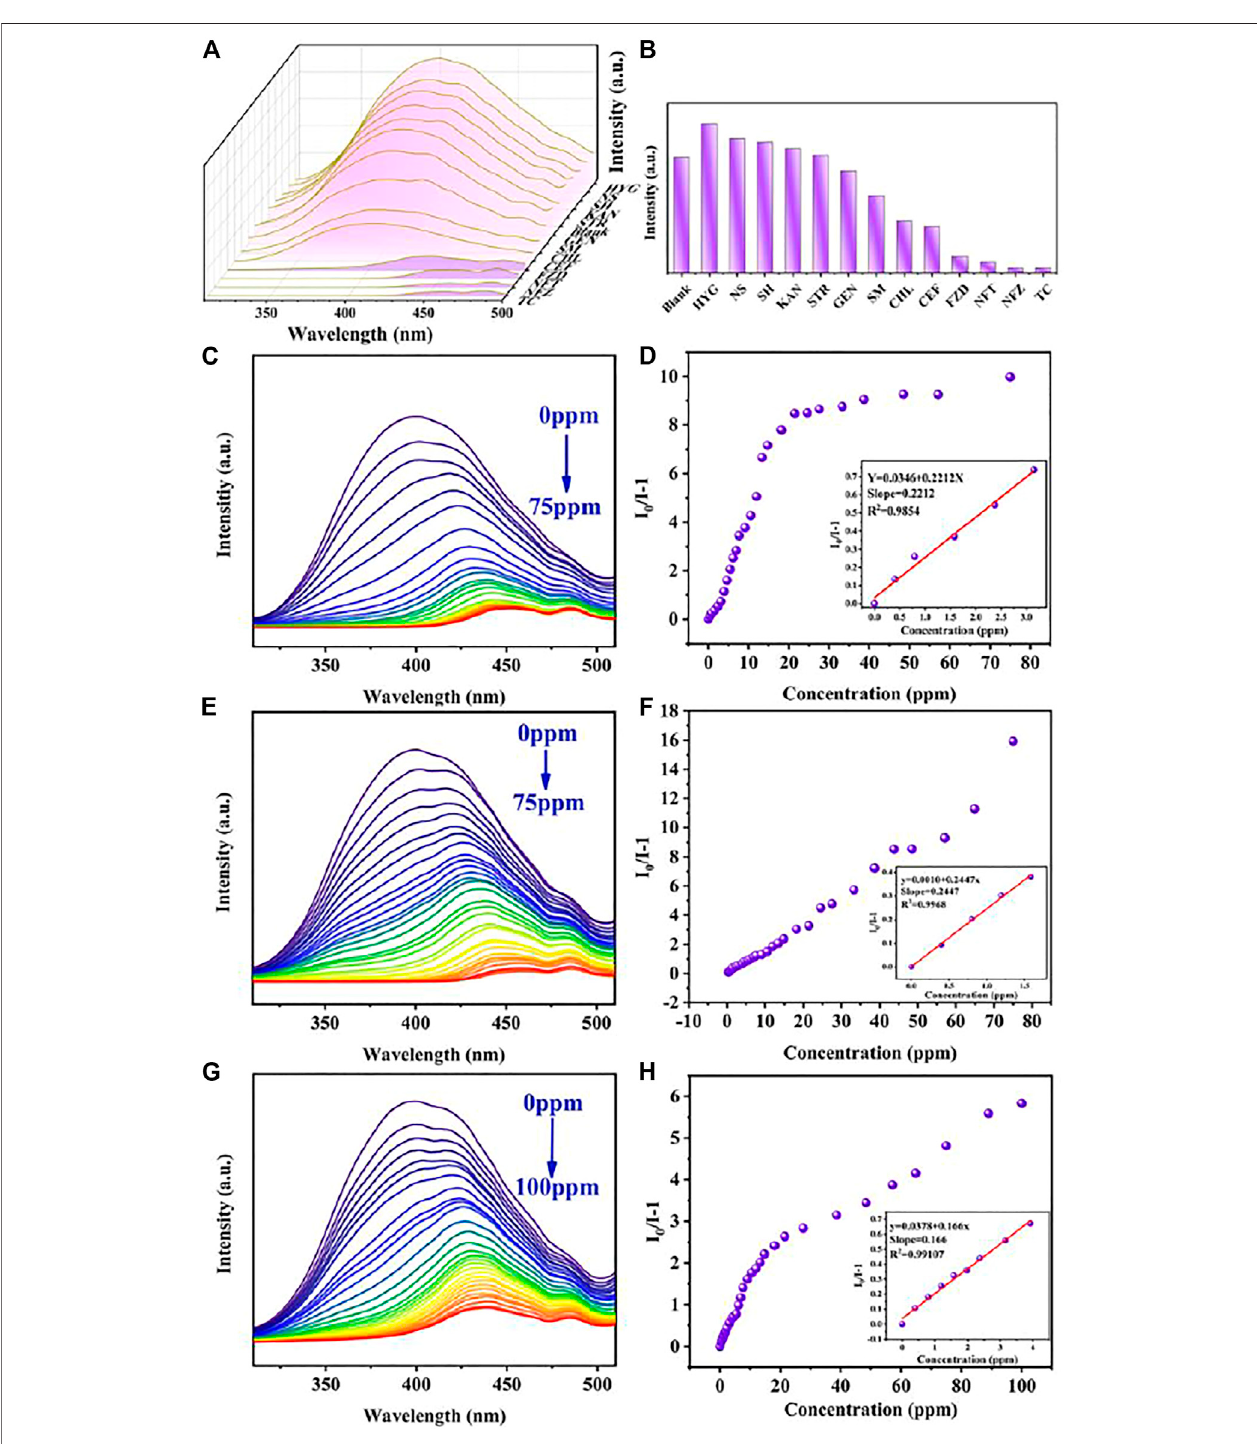
FIGURE 4 | (A) Emission spectra of Cu 0.1 /Zn-MOF immersed in antibiotics. (B) Sensing effects of Cu 0.1 /Zn-MOF on different antibiotics. Photoluminescence spectra of Cu 0.1 /Zn-MOF in aqueous solutions upon incremental addition of NFT (C) , NFZ (E) , and FZD (G) . Stern – Volmer plot of Cu 0.1 /Zn-MOF upon adding different concentrations of NFT (D) , NFZ (F) , and FZD (H) .